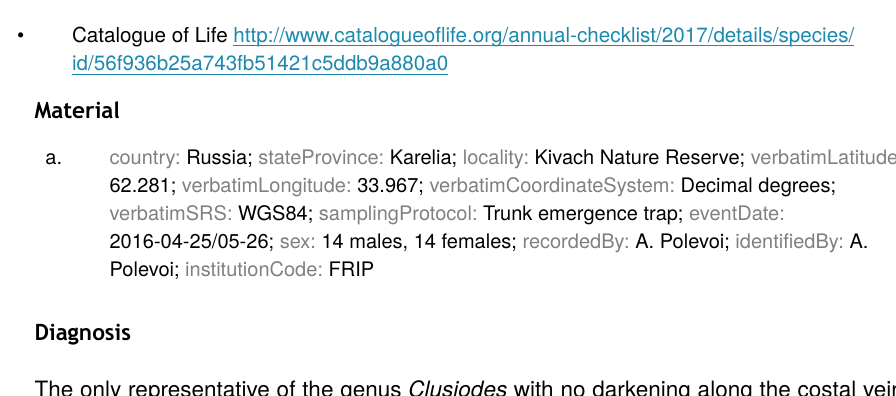
Ecology Saproxylic species, associated with deciduous trees (Krivosheina 2003). This fl y was collected from a wind-broken aspen, colonised by 7 species of macrofungi Table 1. Conservation Red-listed in Leningrad province of Russia (Krivokhatsky and Kuznetsov 2002).